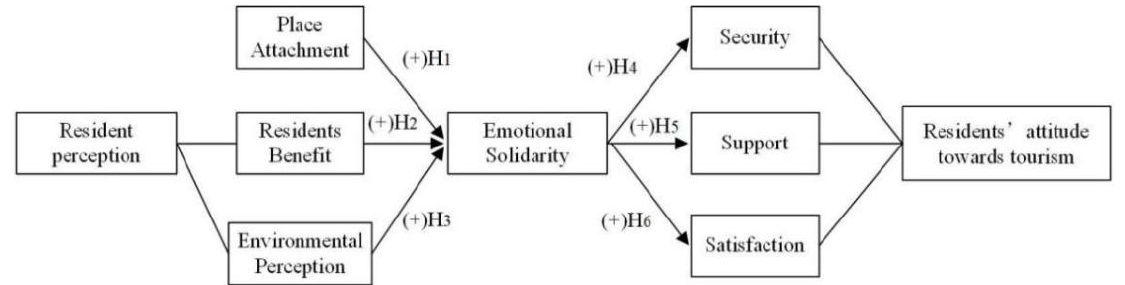
Figure 1. Model of residents’ perceptions and attitudes towards tourism. Hypothesis 1 (H1). Place attachment has a positive effect on emotional solidarity . Hypothesis 2 (H2). Resident benefit has a positive effect on emotional solidarity. Hypothesis 3 (H3). Environmental perception has a positive effect on emotional solidarity. Hypothesis 4 (H4). Emotional solidarity has a positive effect on perception of security. Hypothesis 5 (H5). Emotional solidarity has a positive effect on